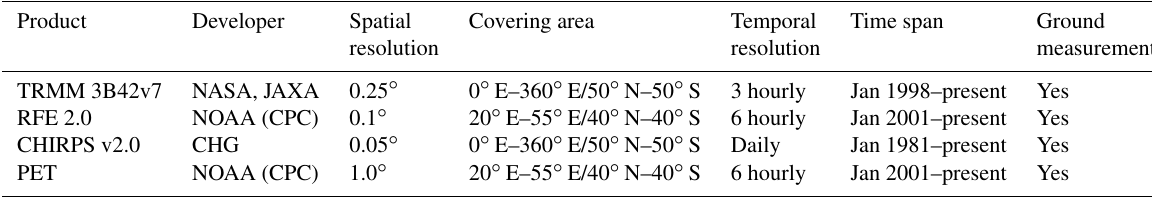
Table 1. Summary of the different precipitation and evapotranspiration satellite products. Product Developer Spatial Covering area